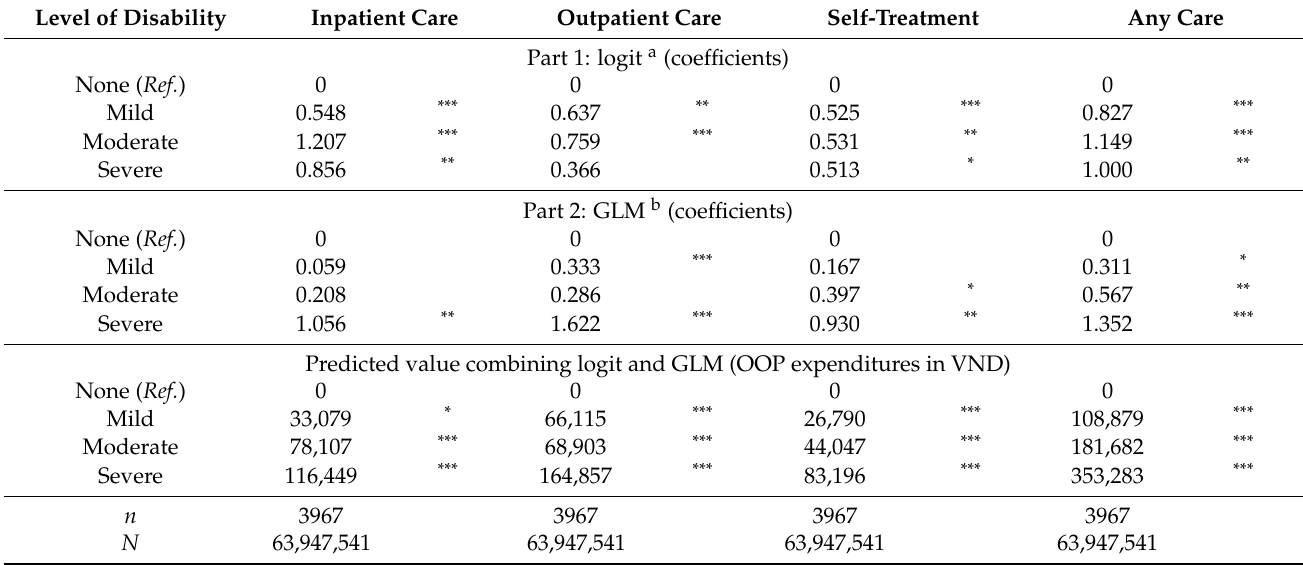
Table 5. Two-part model—relationship between disability and OOP health expenditures. Level of Disability Inpatient Care Outpatient Care Self-Treatment Any Care